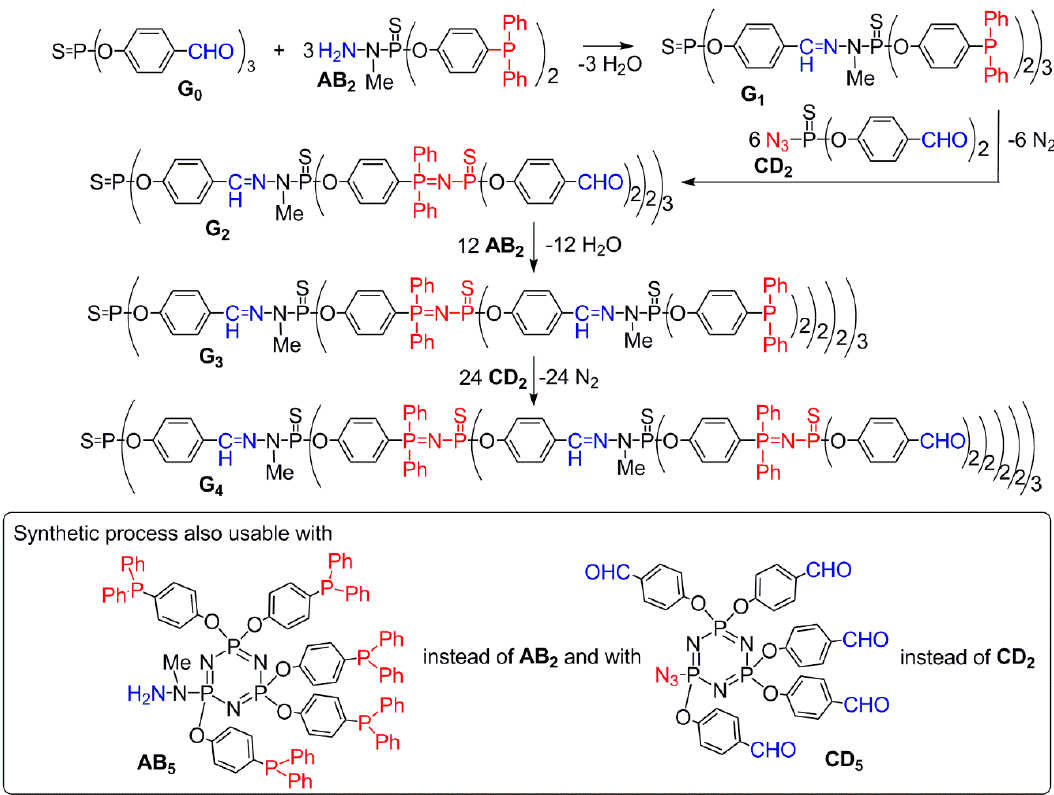
Figure 13. Synthesis of layered dendrimers using two branched orthogonal monomers of type AB